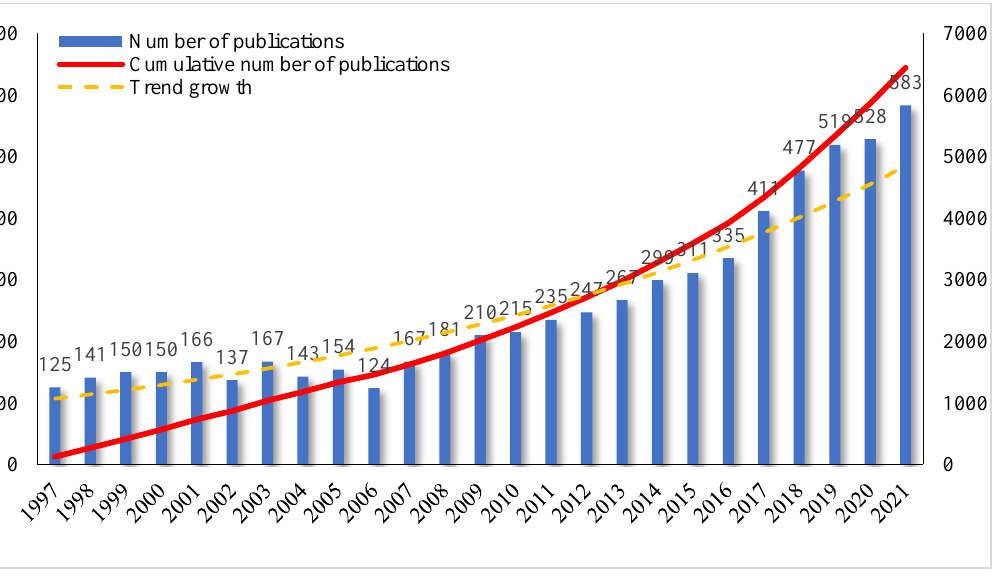
Figure 1. Growth trend, annual number and cumulative number of publications related to hydrogen embrittlement.